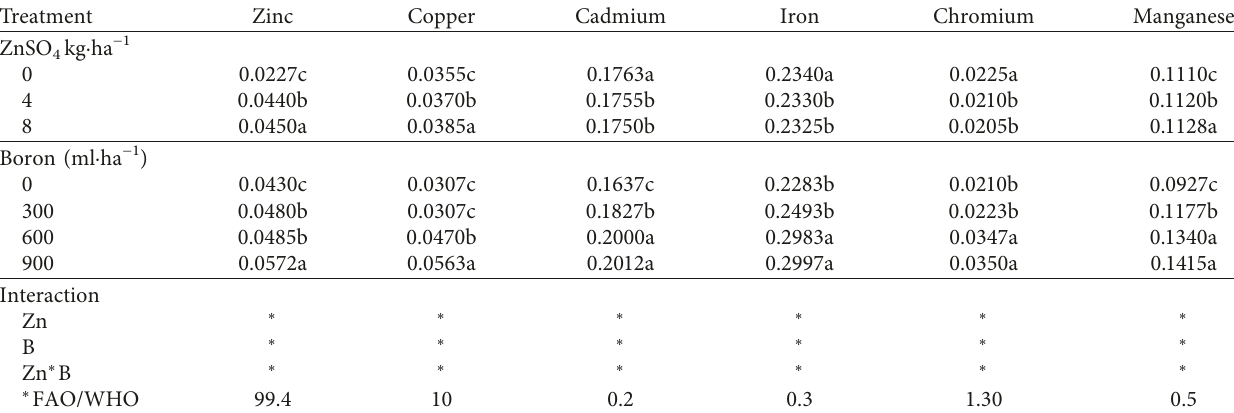
Means in a column under any given treatment followed by the same letters do not differ significantly at 0.05 level of probability using the Duncan multiple range test (DMRT). ∗ Significant at 0.05 level of probability. Table 6: Effect of zinc and boron fertilizers on some heavy metal concentrations (mg · kg − 1 ) in groundnut seeds (Pooled data of 2016 and 2017 cropping